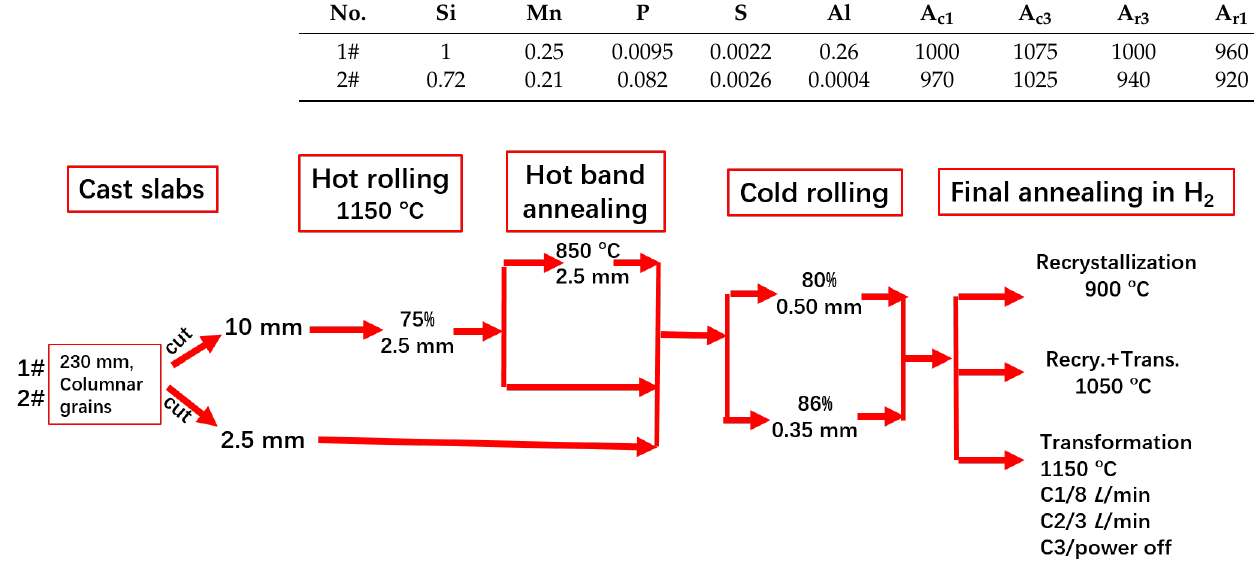
Figure 1. Schematic diagram of processing steps.